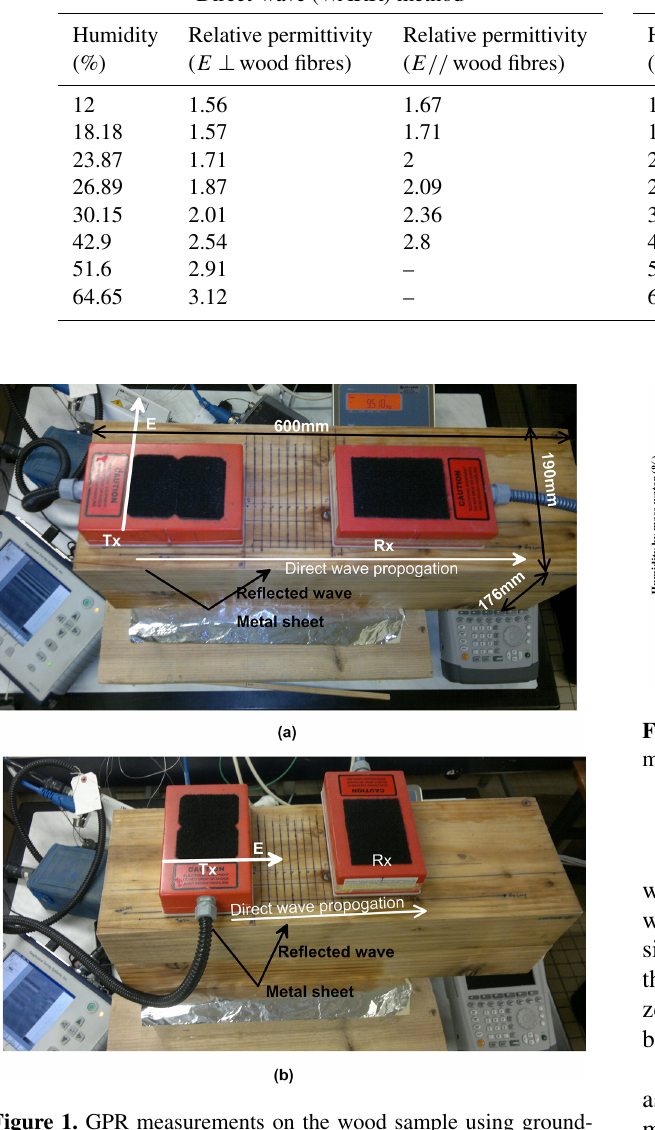
Figure 1. GPR measurements on the wood sample using ground- coupled antennas and the WARR technique. (a) Electric field is per- pendicular to the fibres. (b) Electric field is parallel to the fibres.